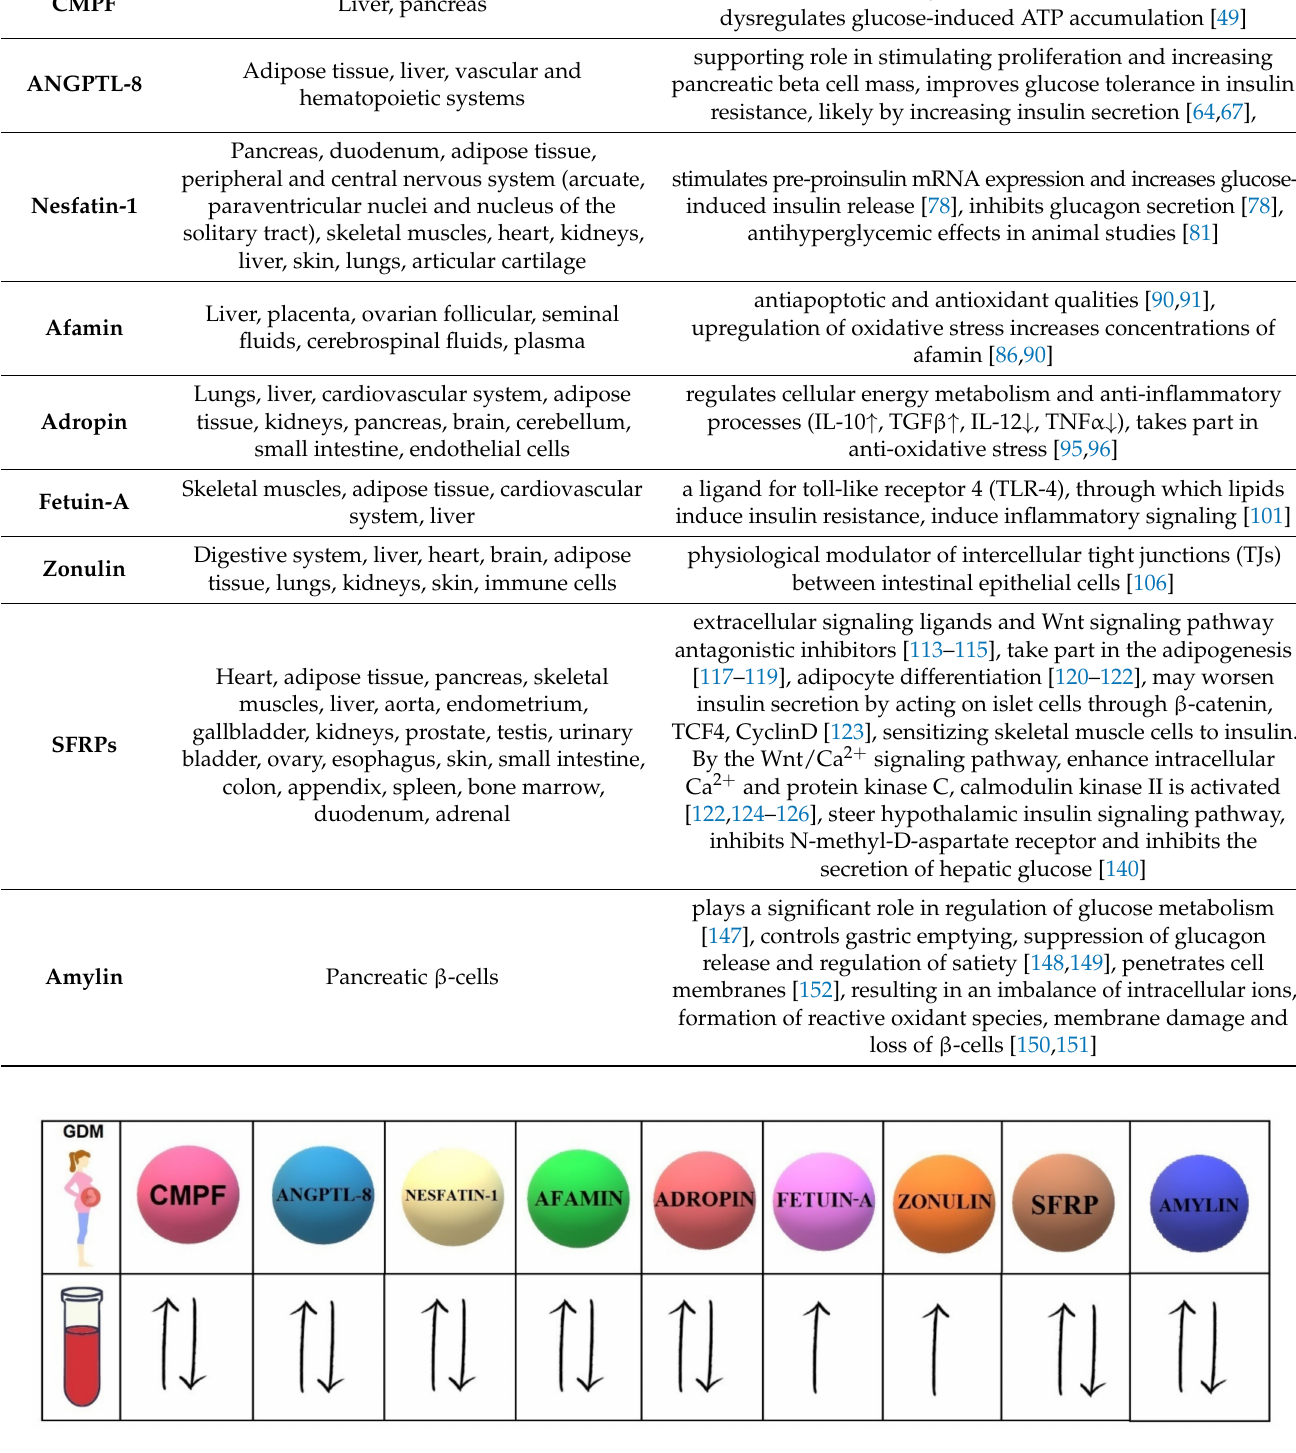
Figure 1. Concentrations of selected biomolecules in the serum of GDM patients compared to their concen- trations in the serum of healthy pregnant women. CMPF (3-carboxy-4-methyl-5-propyl-2-furanpropanoic acid); ANGPTL-8 (angiopoietin-like protein-8); SFRPs (secreted frizzled-related